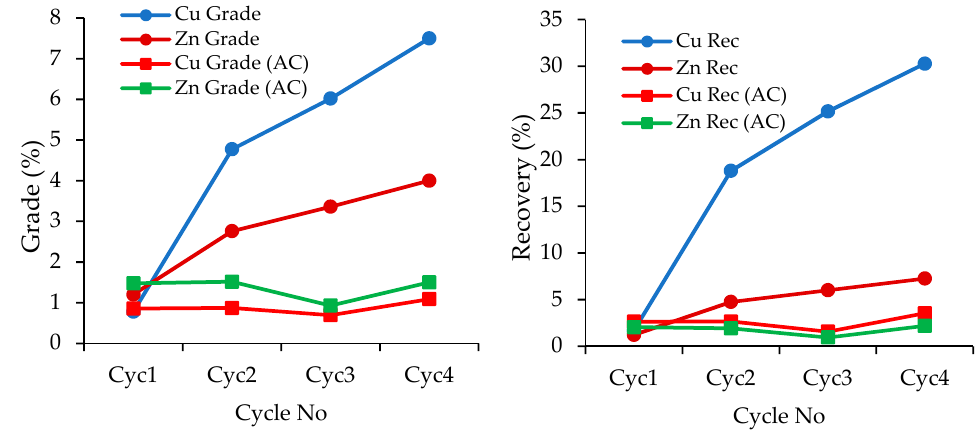
Figure 10. Cu and Zn grades and recoveries to pre-flotation concentrate with and without the use of activated carbon (AC) for water treatment.